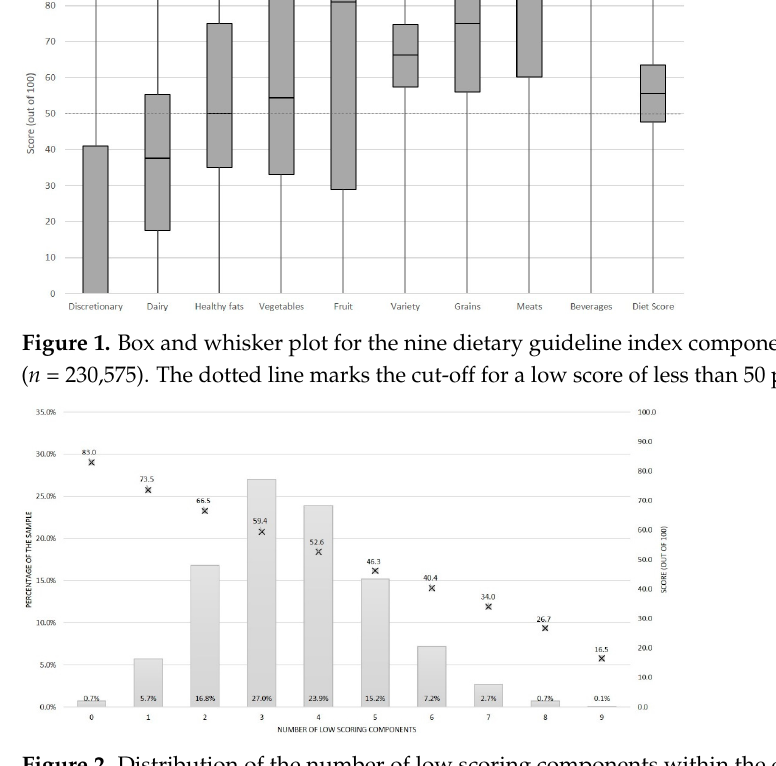
Figure 1. Box and whisker plot for the nine dietary guideline index components and total diet score ( n = 230,575) . The dotted line marks the cut-off for a low score of less than 50 points of a pos- sible 100.